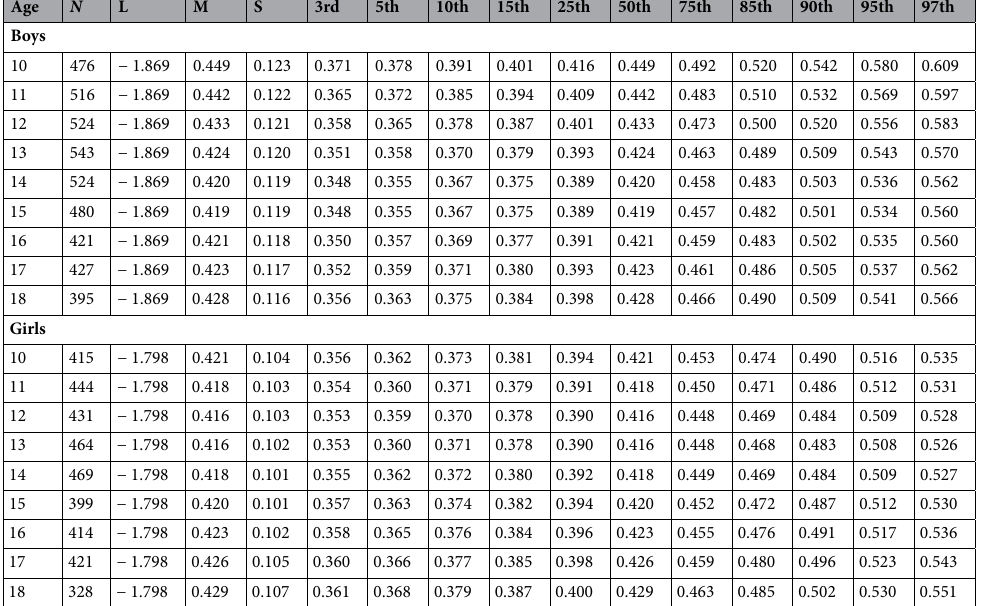
Table 2. Distribution of waist circumference-to-height ratio (WHtR) in Korean children and adolescents according to sex ( n = 8091).